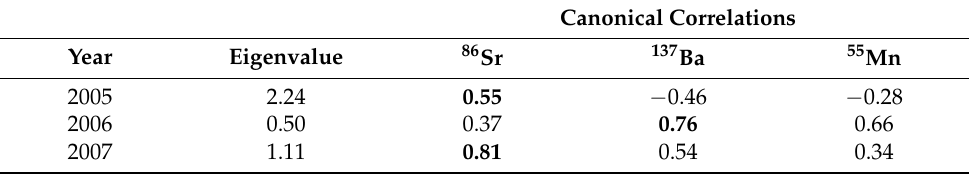
Table 1. Results of multivariate discriminant function analysis of isotopic concentrations of strontium ( 86 Sr), barium ( 137 Ba), and manganese ( 55 Mn) from northern pike otoliths collected in the Yampa River Basin, Colorado, USA. Only canonical axes explaining greater than 10% of the variation were included. All canonical axes shown were significant ( p < 0.001). The element with the highest correlation for each analysis is shown in bold.